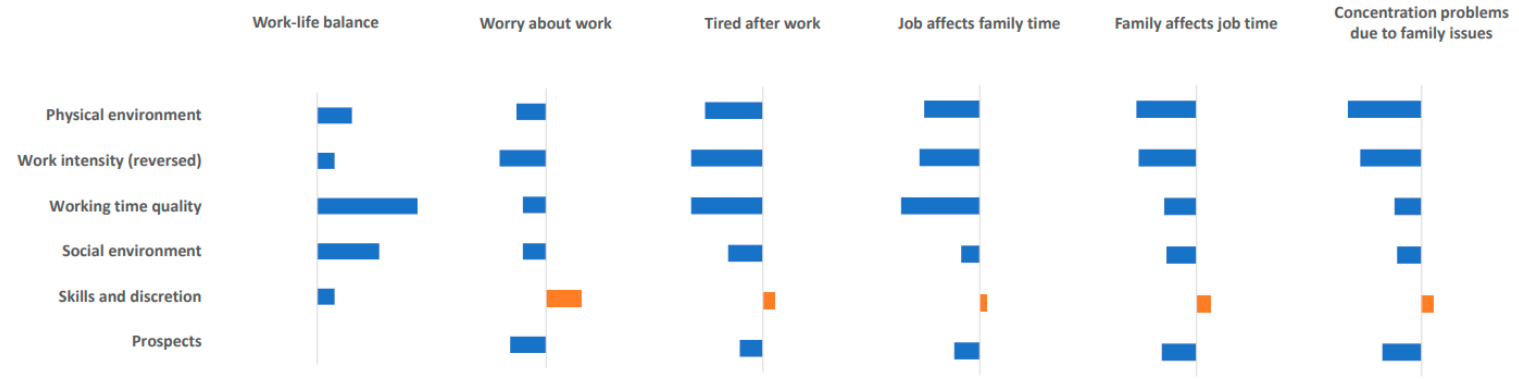
Figure 2. Association between job quality indices and work–life balance (Female).